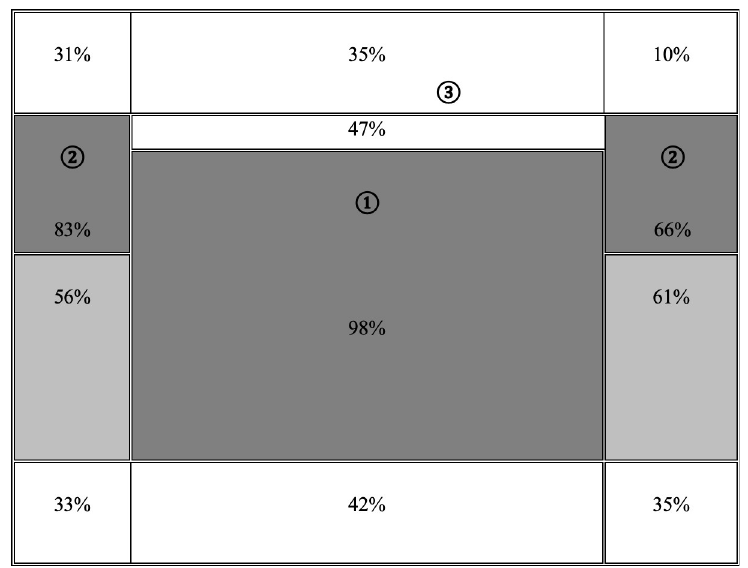
Fig 1. Order and percentage of fixations by internet users on a web page. Schema taken from Nogier, Bouillot, and Leclerc [71], p. 33. The percentage corresponds to the proportion of internet users who fixate the relevant area at least